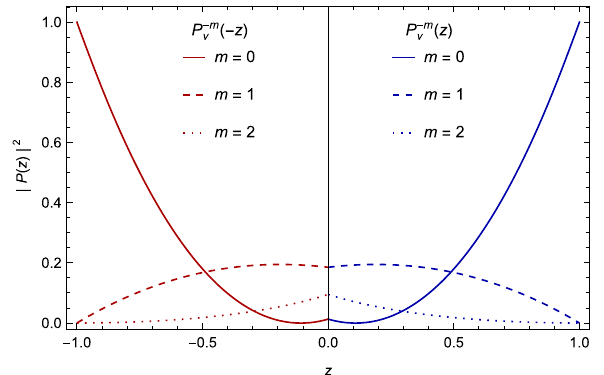
Fig. 14 (AdS) Case 2: a > 0. The first three squared QBS angular wave eigenfunctions as a function of the new polar coordinate z ; a = 0 . 20, R = 1, N = 0, M = 0 .